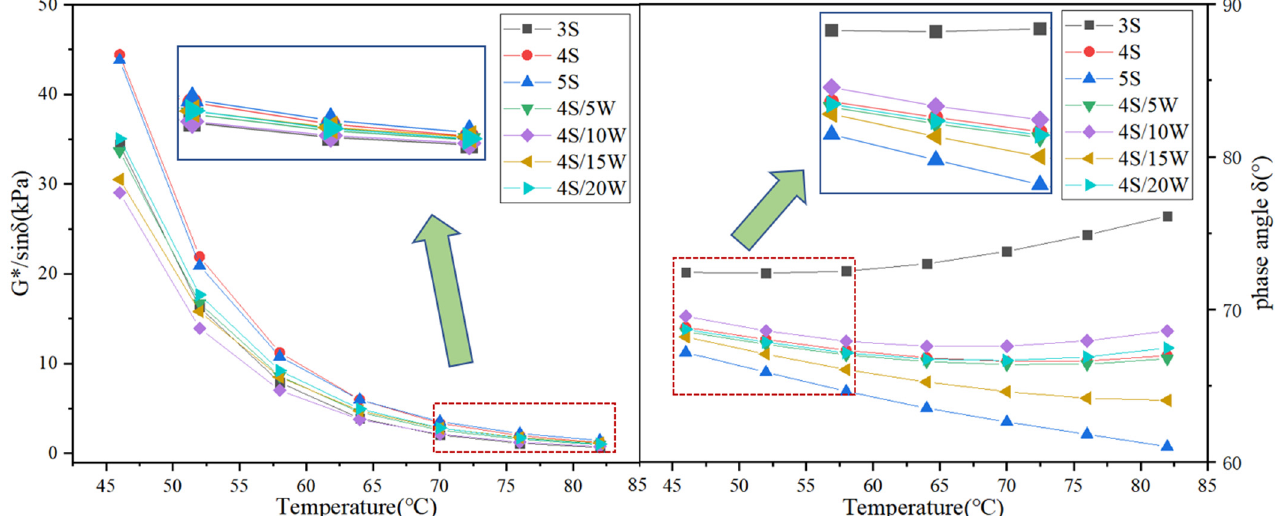
Figure 6. G * /sin δ and δ of WPU/SBS composite modified asphalt.